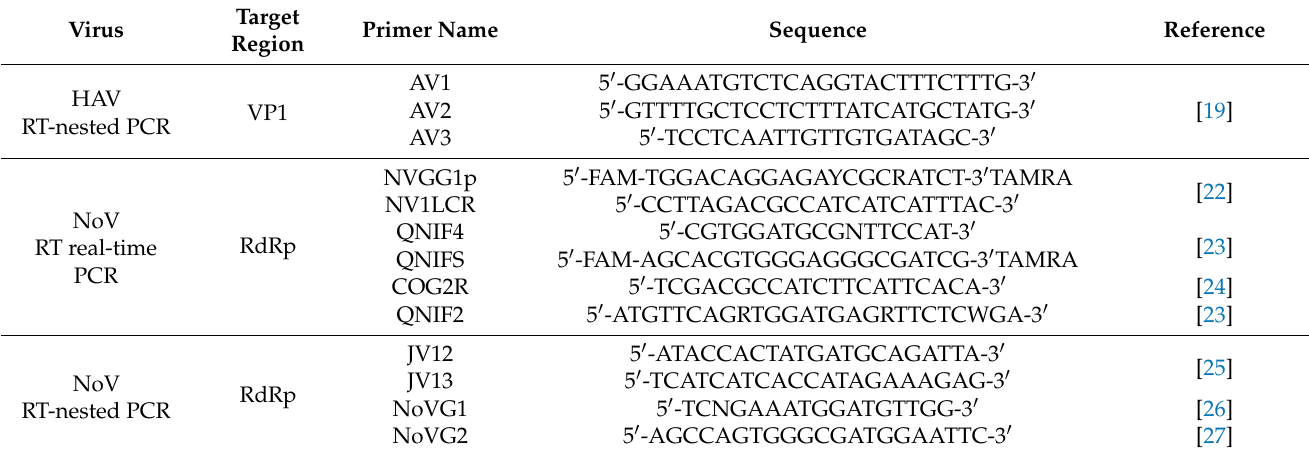
Table 1. Details of primers and probes used in this